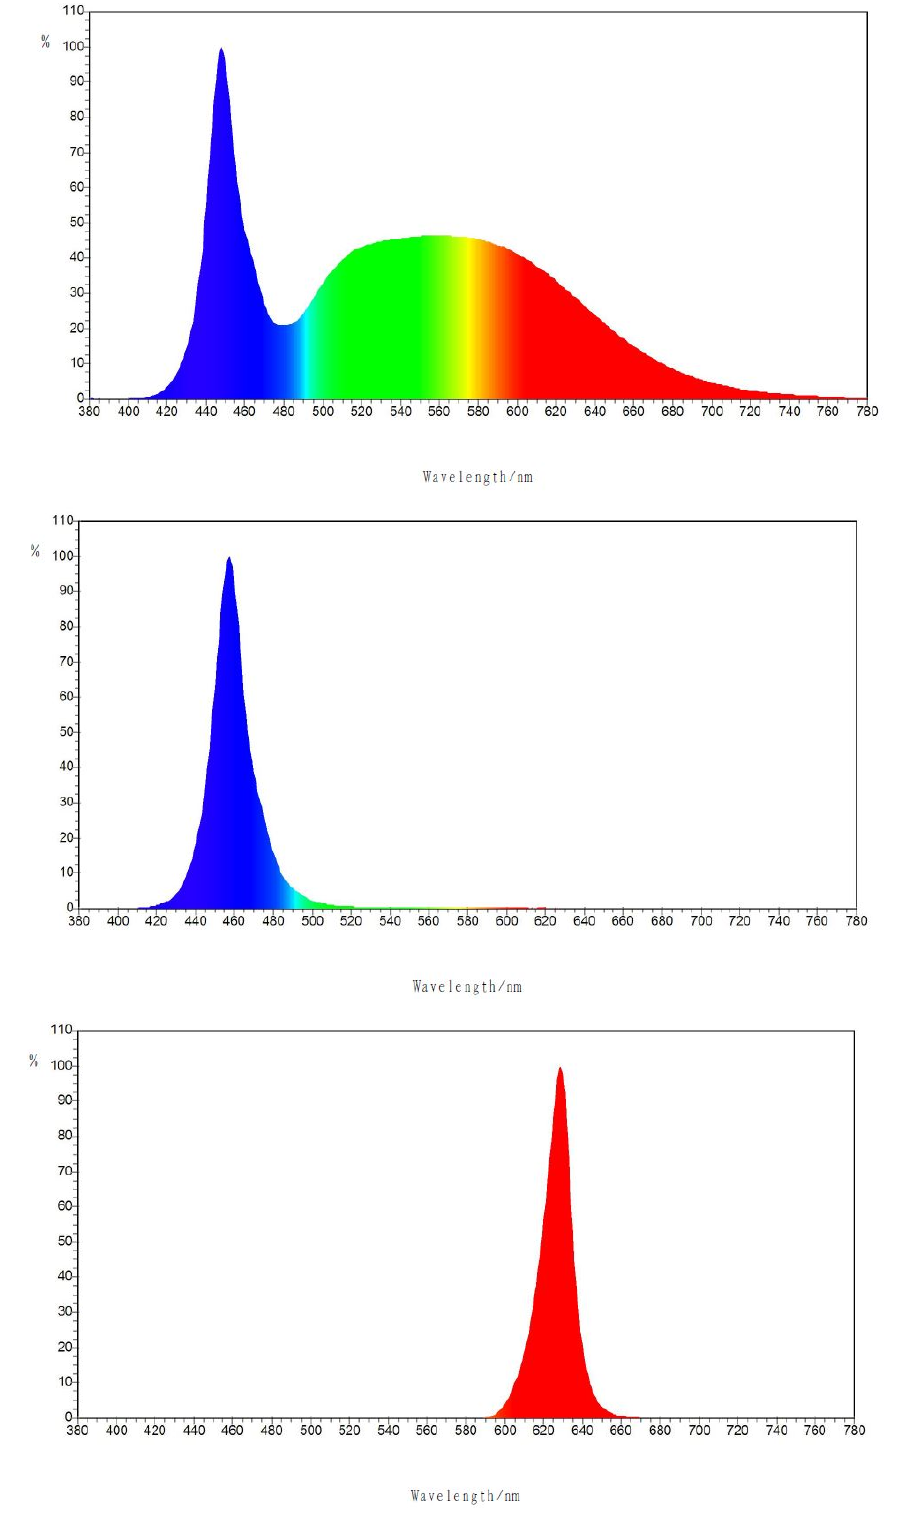
Figure 1. The wave length distribution of the white, blue and red light emitting diode (LED) lamp in the experiment. The peak wavelengths for blue and red light were 630 and 460 nm, determined by Integrating Sphere, Zvision, Beijing,